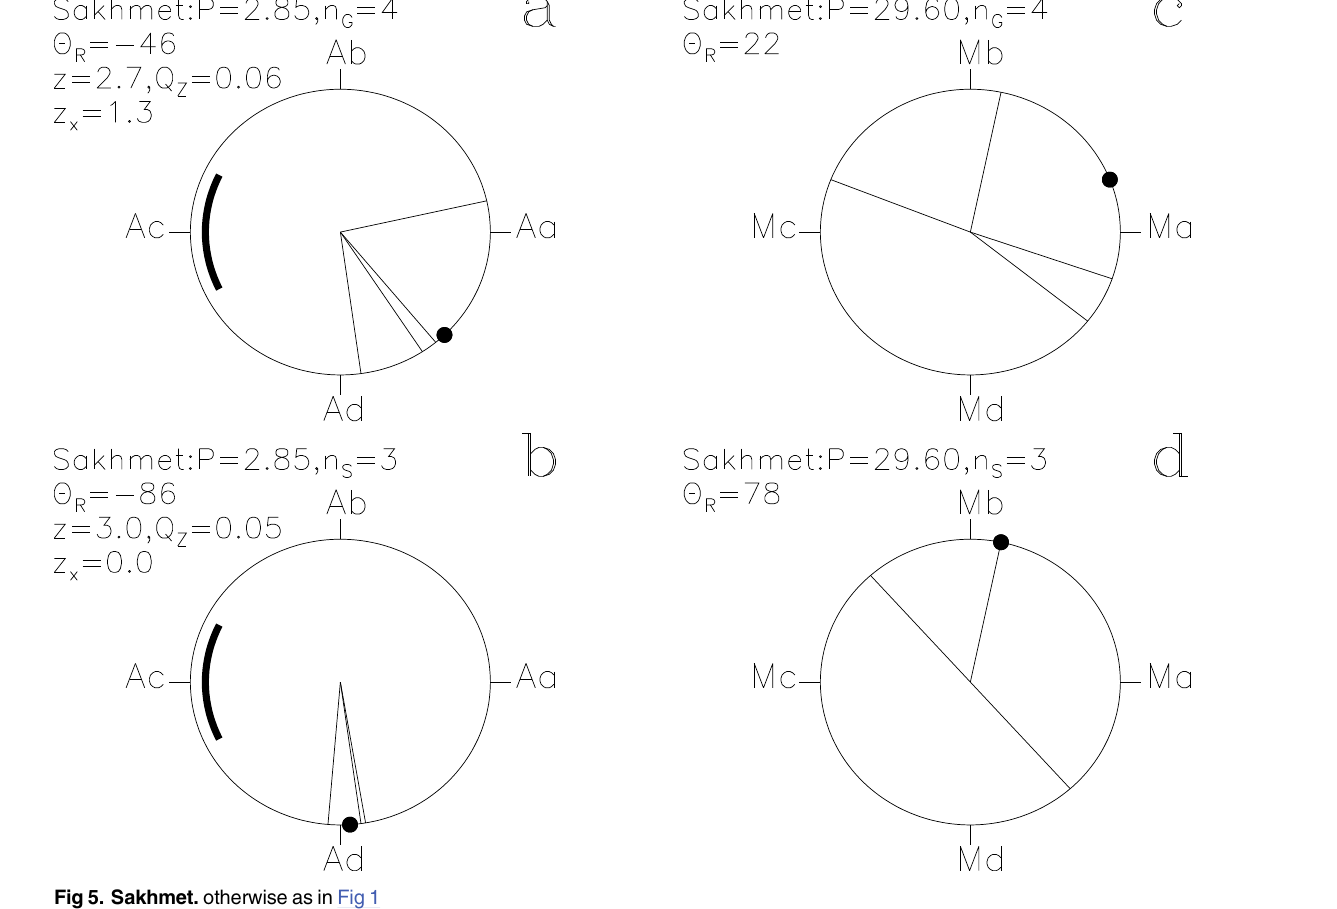
Fig 5. Sakhmet. otherwise as in Fig